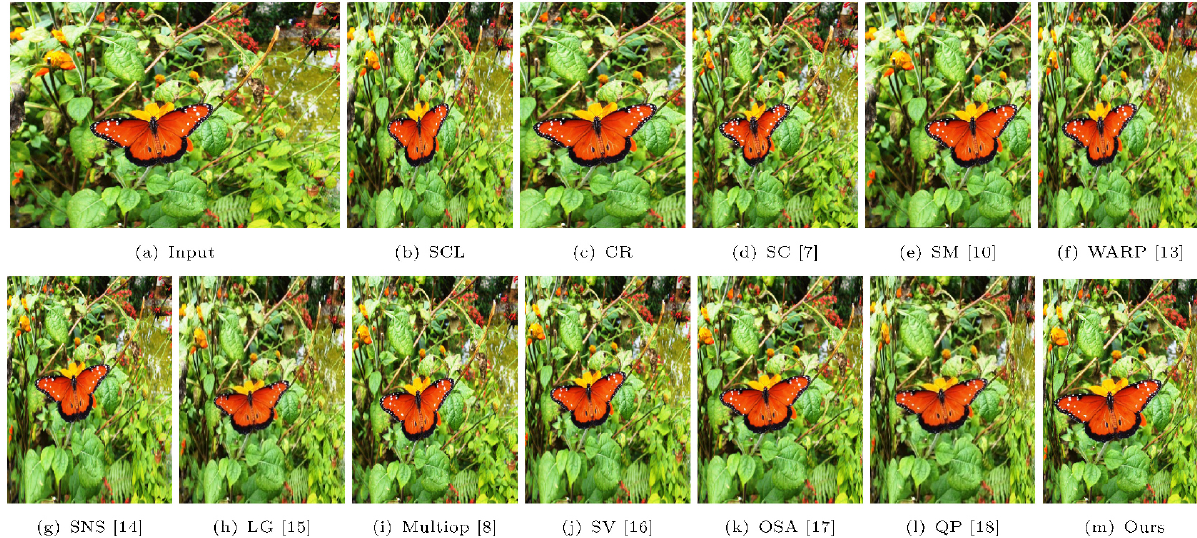
Fig. 10 Results from the proposed warping method and 11 classic retargeting methods, resizing an image to 50% of its original